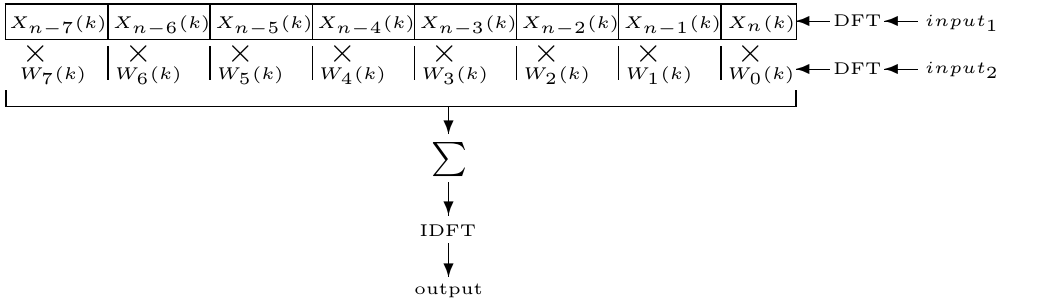
Figure 11. Partitioned time-varying